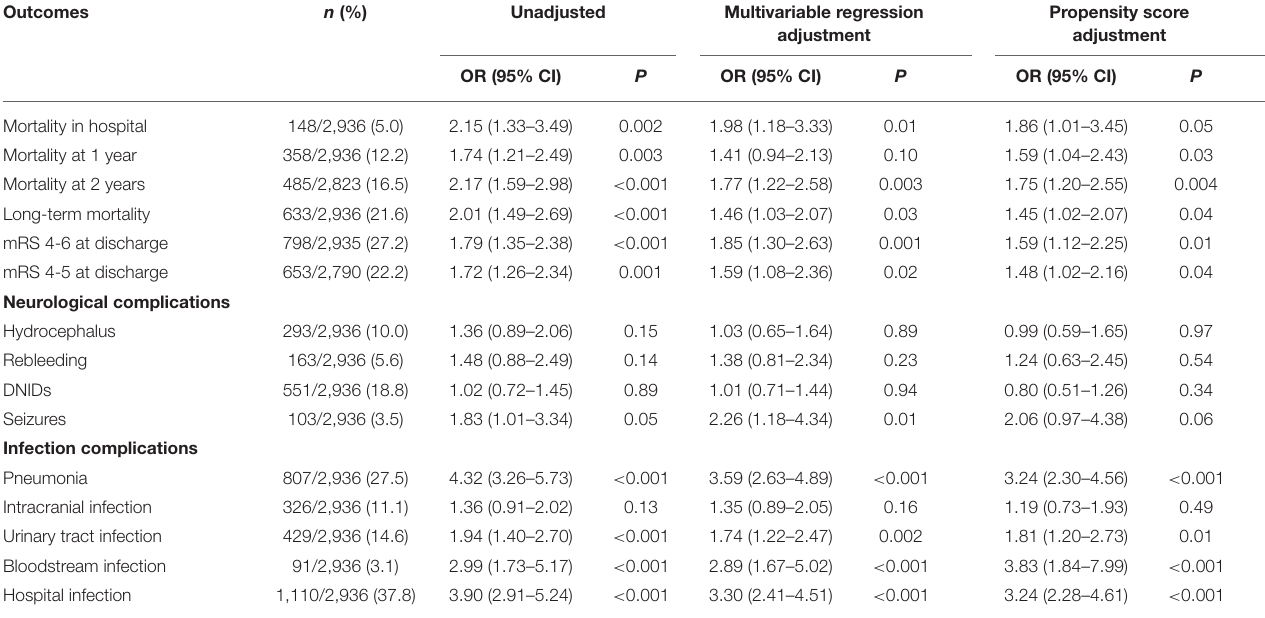
Propensity score adjustment adjustment